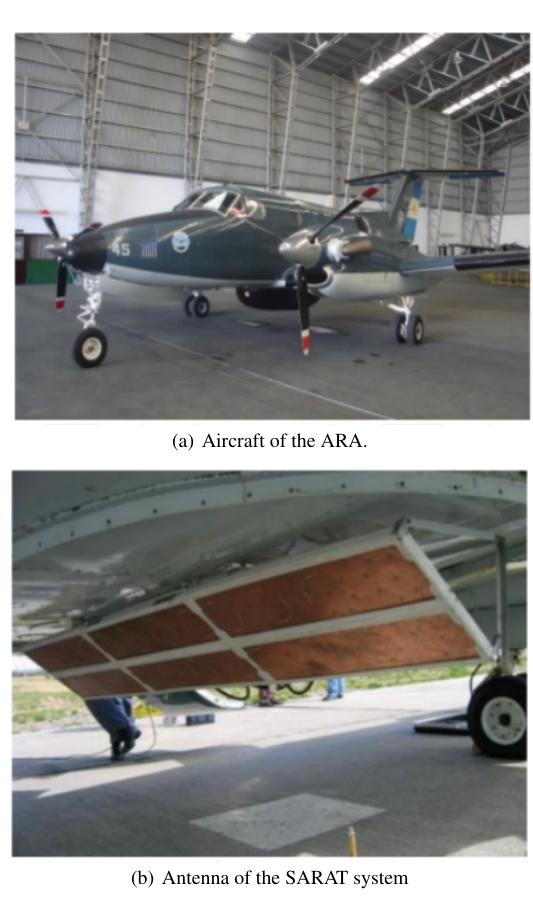
Figure 1. The SARAT system (Notarnicola, Solorza,